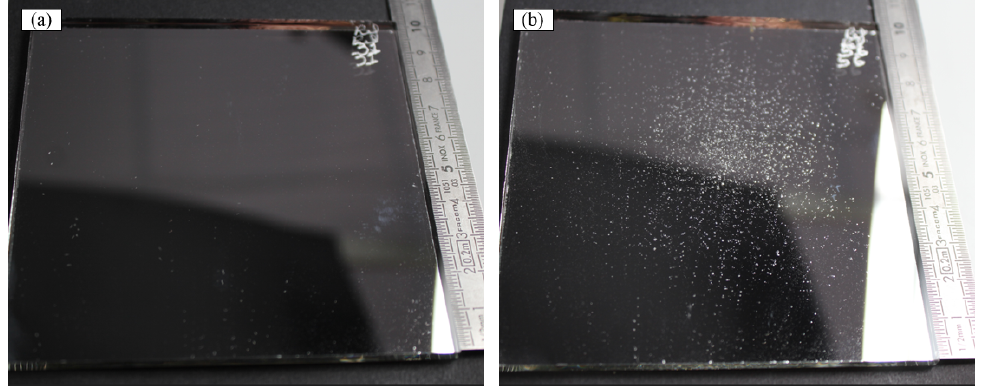
Figure 4. Tested samples; ( a ) Uncoated intact, ( b ) Uncoated eroded.